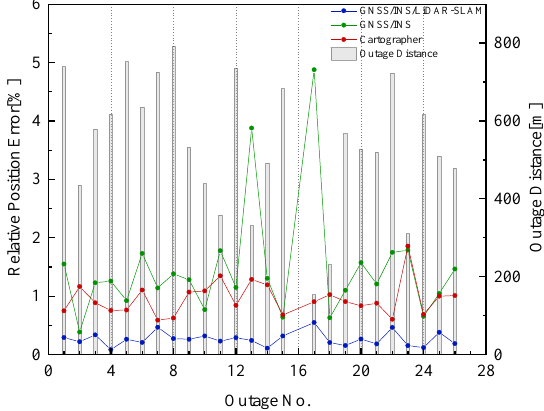
Figure 12. Relative position errors in the GNSS outage simulation tests.